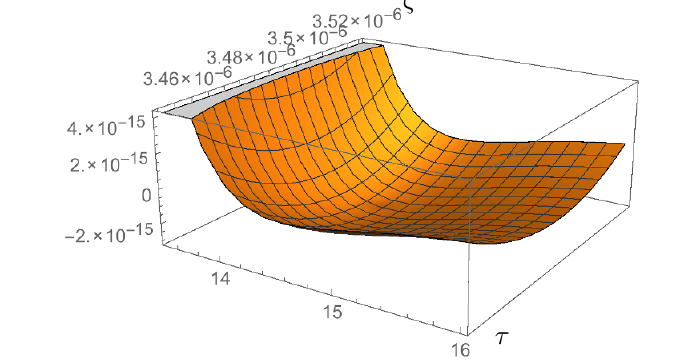
Figure 5 . Potential V ( (cid:16); (cid:28) ) for (cid:27) = 0, (cid:18) = (cid:0) (cid:25)= 2 and the choice of parameters: M = 10, K = 10, g s = 1 = 2 and A = a =